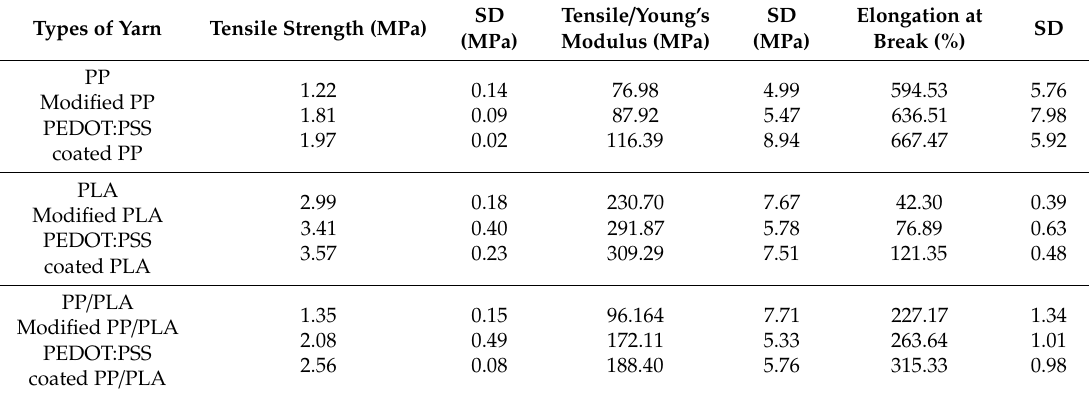
Table 3. Mechanical properties of thermoplastic